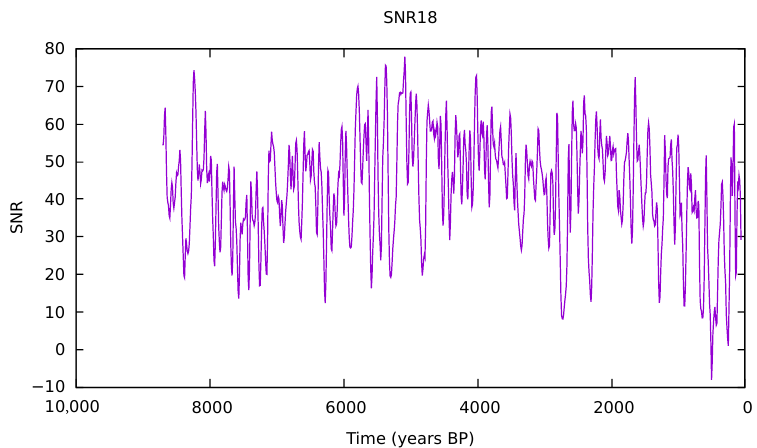
Figure 1. ( Top panel ) Sunspot number reconstruction (SNR04), reprinted from Solanki et al. [30] from dendrochronologically dated radiocarbon concentrations in tree rings. ( Middle panel ) Total solar irradiance reconstruction (TSIR12), reprinted from Steinhilber et al. [31] from a combination of several 10 Be ice core records from Greenland and Antarctica with the global record of 14 C in tree rings. ( Bottom panel ) Sunspot number reconstruction (SNR18), reprinted from Wu et al. [32] using a Bayesian approach applied on six 10 Be time series from Greenland and Antarctica, and the global 14 C series. For all the plots, time is given as years before present (BP), where present refers to 1950 AD.